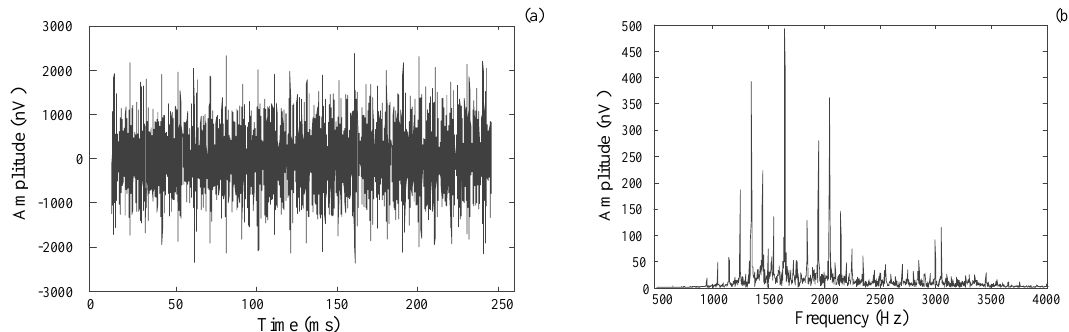
Figure 9. Pure noise r [ n ] obtained by stacking. ( a ) The pure noise in the time domain; ( b ) the corresponding amplitude spectrum.